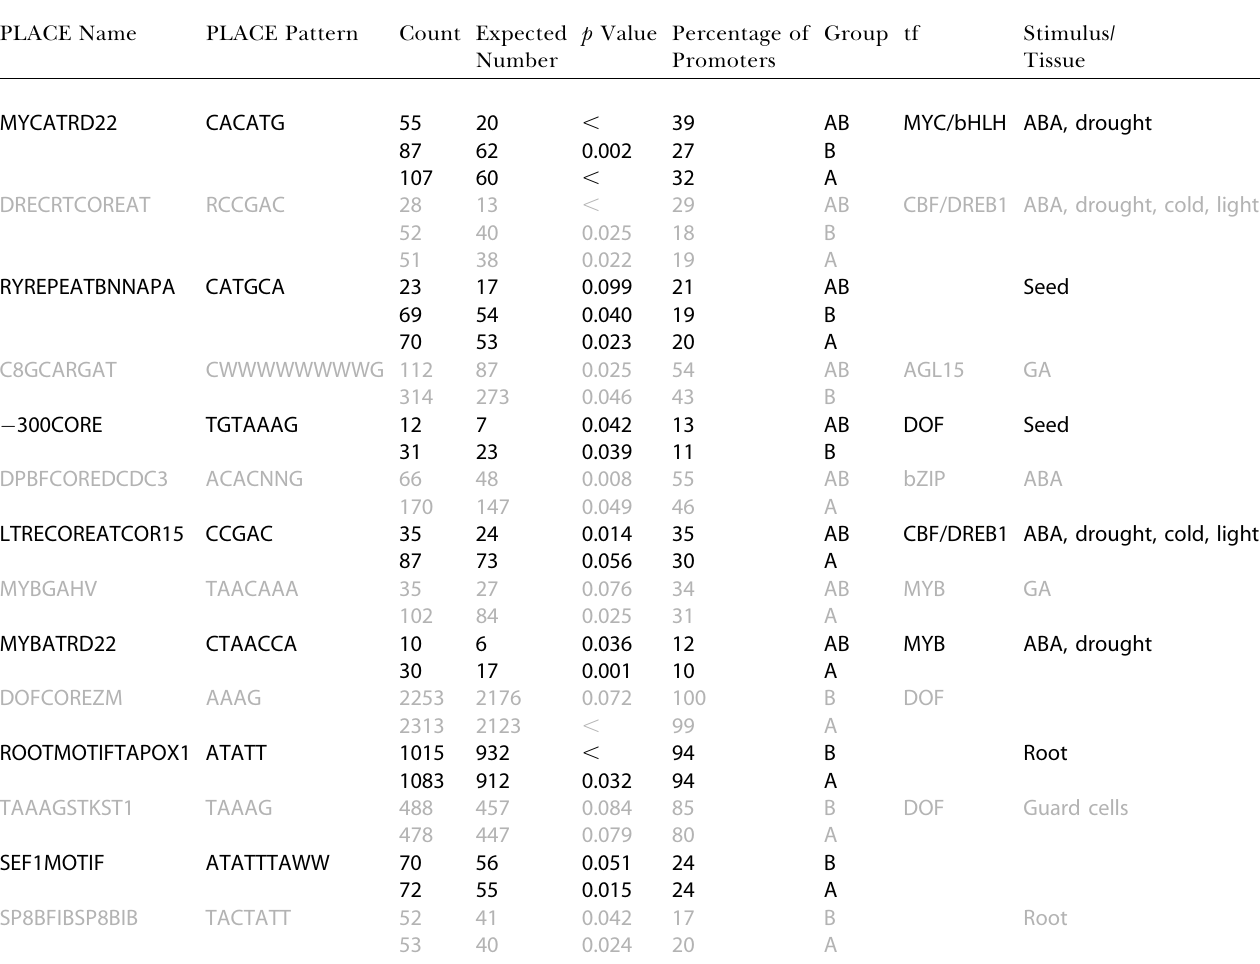
Table 2. PLACE Motifs Enriched in Promoters of Multiple Groups PLACE